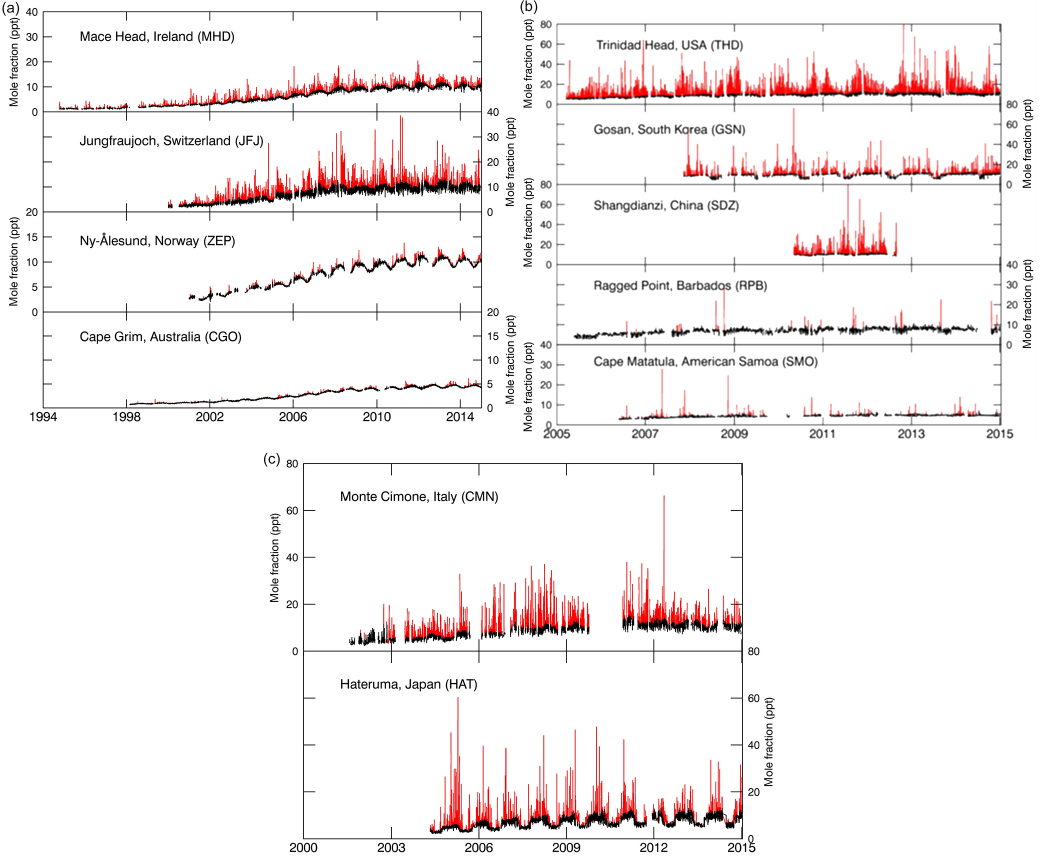
Figure 2. (a) Time series of HFC-152a mole fractions (ppt) recorded at the four monitoring stations with combined ADS and Medusa data. (MHD, JFJ, ZEP and CGO), (note the different y axis scales). Data have been assigned as baseline (black) and non-baseline (red) using the AGAGE pollution identification algorithm. (b) Time series of HFC-152a mole fractions (ppt), recorded with the Medusa GC-MS instruments at the five AGAGE monitoring stations (THD, GSN, SDZ, RPB, and SMO). Data have been assigned as baseline (black) and non-baseline (red) using the AGAGE pollution identification algorithm. (c) Time series of HFC-152a mole fractions (ppt) recorded with the GC-MS instruments at the two affiliated AGAGE stations CMN and HAT. Data have been assigned as baseline (black) and non-baseline (red) using the AGAGE pollution identification